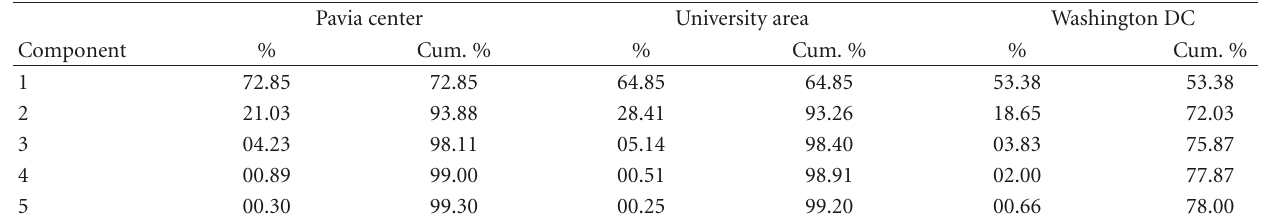
Table 4: PCA: Eigenvalues and cumulative variance in percentages for the three hyperspectral data sets. Pavia center